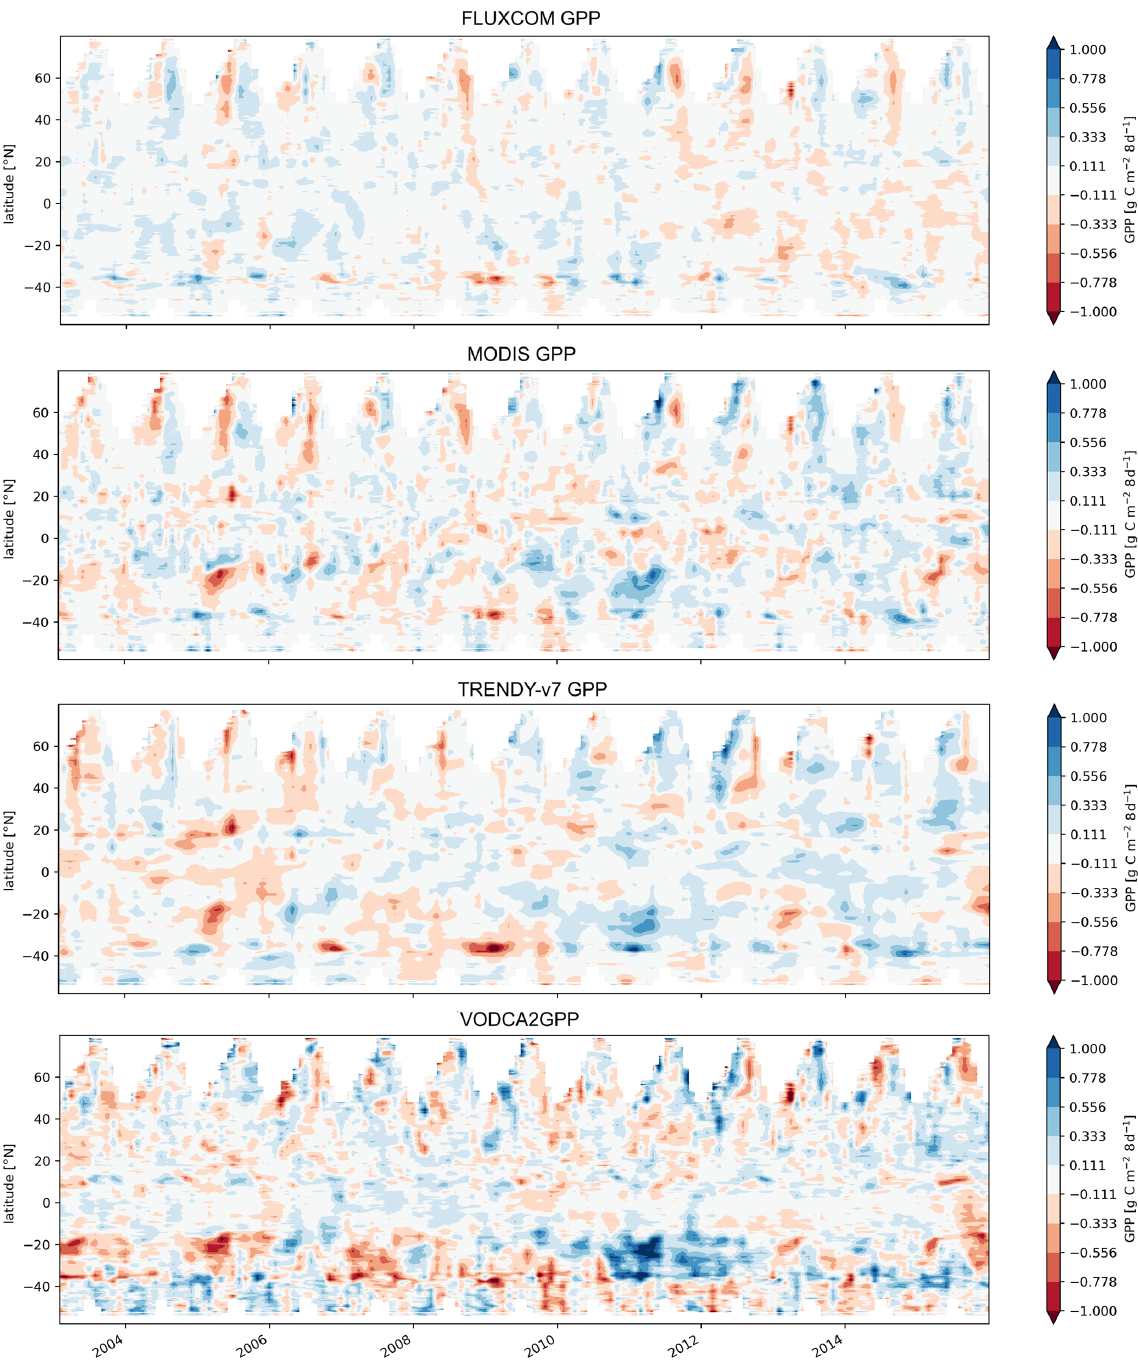
Earth Syst. Sci. Data, 14, 1063–1085, 2022